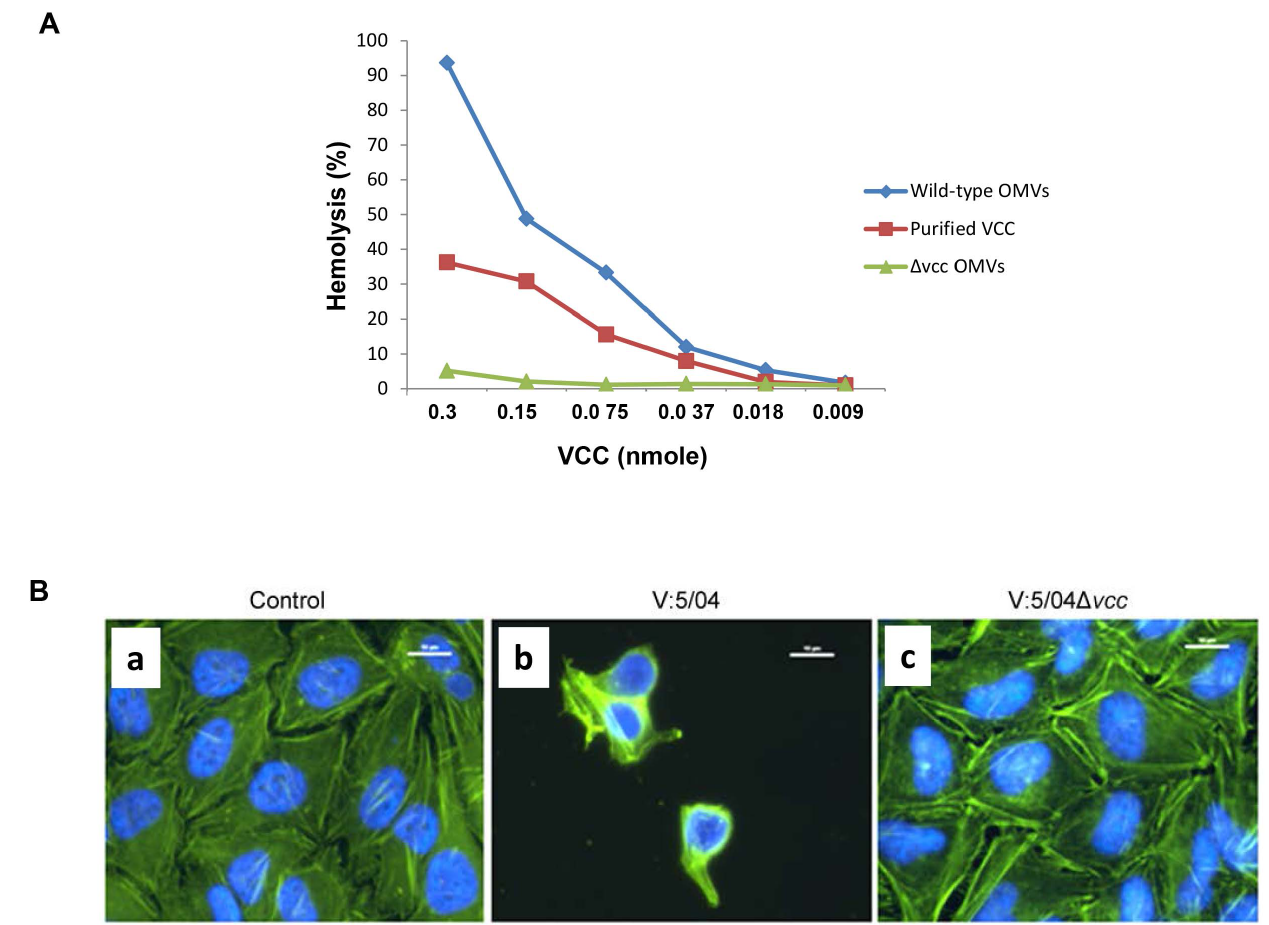
Figure 6. Hemolytic and cytotoxic effects of OMV-associated VCC. (A) Quantification of hemolytic activity of VCC in OMVs and comparison with activity of purified VCC. Contact hemolytic assay using 5% rabbit red blood cells was performed as described in the materials and methods. (B) Cytotoxic effect on HeLa cells (a) Control cells were treated with Tris buffer; (b) cells were treated with OMVs from wild type NOVC strain V:5/04; (c) cells were treated with OMVs from the D vcc mutant. After 6 h the HeLa cells were fixed, permeabilized, and then subjected to staining as described in the materials and methods. Staining, actin filament (green) and nucleus (blue). Magnification, 6 1000. Bars=10 m m.